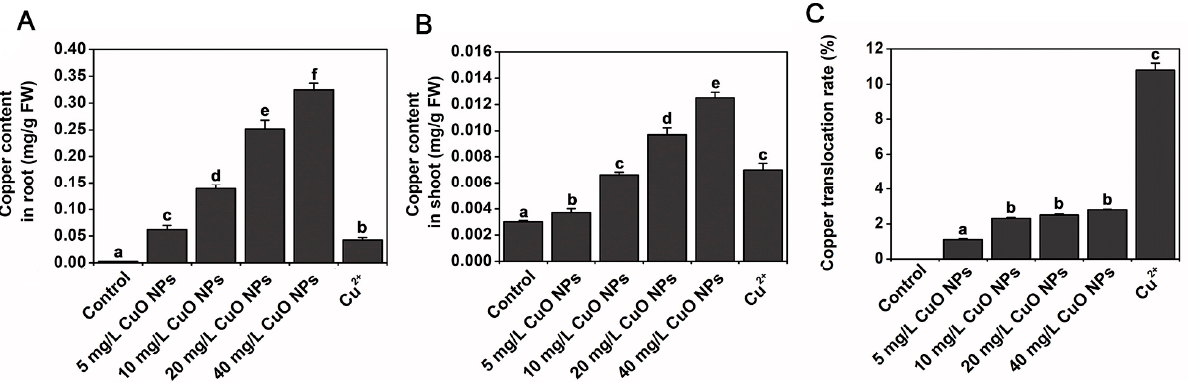
Figure 4. Effect of CuO NPs and Cu 2+ on copper uptake and transfer. ( A , B ) Effect of CuO NPs (0–40 mg/L) and Cu 2+ (1.4 mg/L) on copper accumulation in roots and shoots. ( C ) Effect of CuO NPs (0–40 mg/L) and Cu 2+ (1.4 mg/L) on copper transfer in roots and shoots. Lowercase ‘a to f’ indicated the significant different p < 0.05 in histogram. Reprinted with permission from Ref. [37].